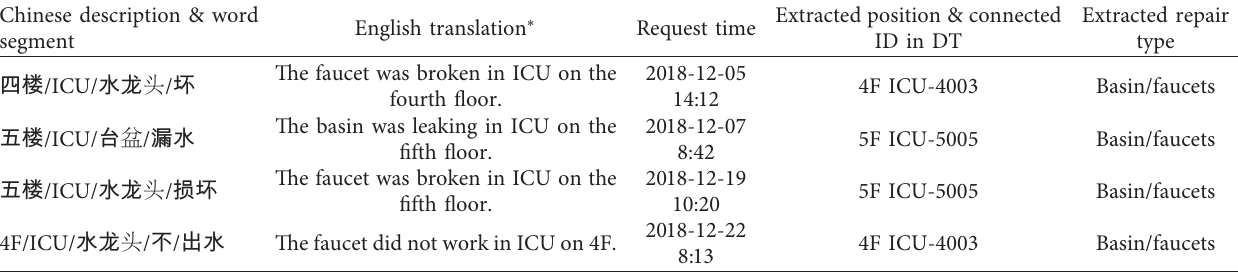
Table 3: A pattern of frequent repairs.